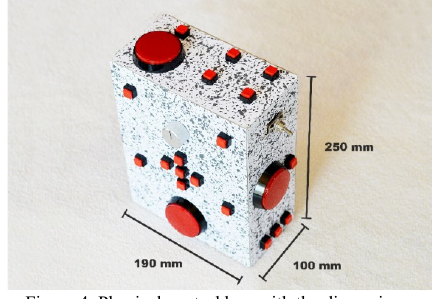
Figure 4. Physical control box with the